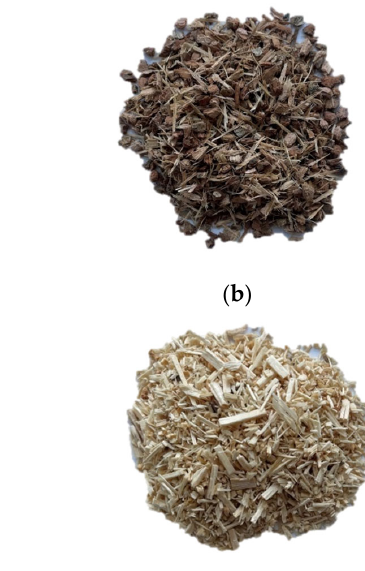
Figure 1. Materials used for the production of boards: ( a ) bark particles before grinding; ( b ) bark particles after grinding; ( c ) wood chips; ( d ) sawdust .